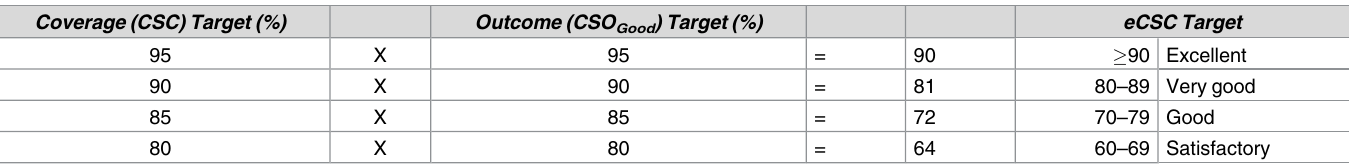
Table 1. Proposed global targets for effectivecataract surgical coverage(eCSC) Coverage (CSC) Target